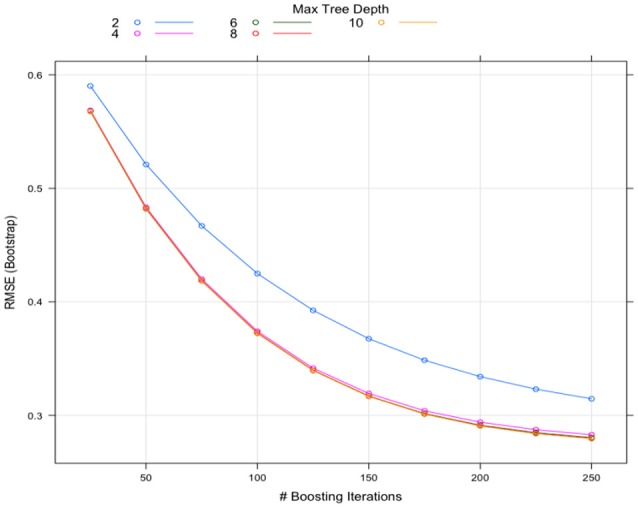
The Gradient Boosting tuning results.